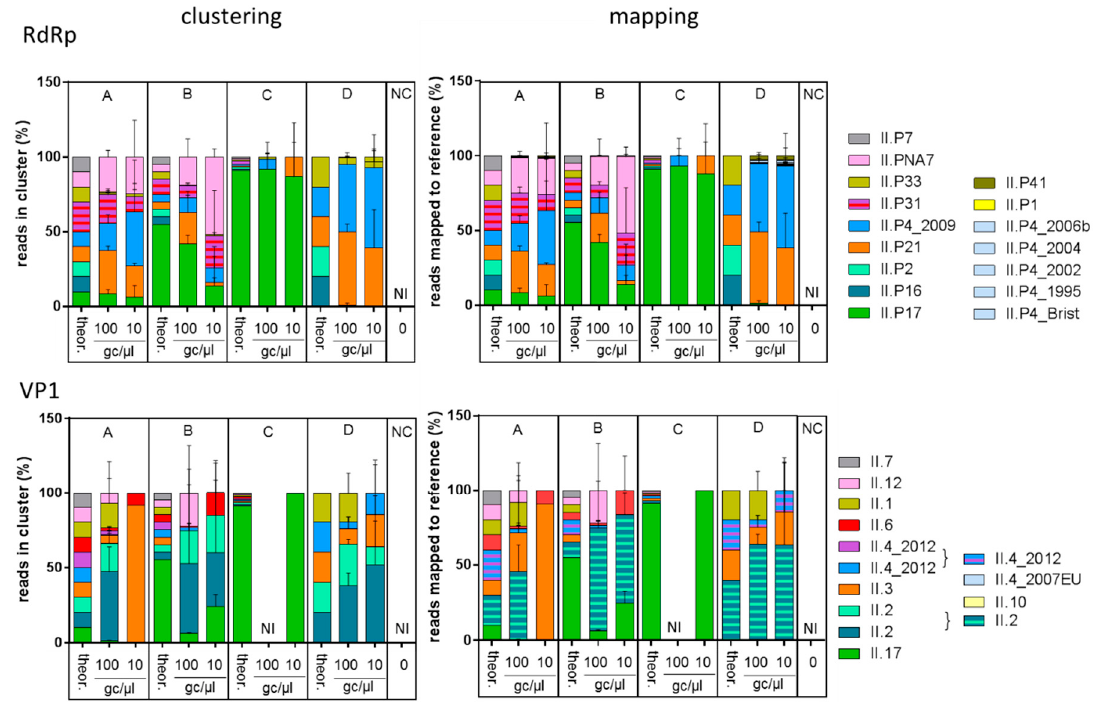
Figure 1. Relative abundance of NoV GII P-types and genotypes identified in the artificial samples. For each nucleic acid pool (A, B, C, D) and dilution (100 and 10 gc/ μ l), and the negative controls (NC), the proportion of reads assigned to a given genotype is depicted as the mean of the replicates with the standard deviation as error bars, for clustering (left) or mapping (right) analysis of RdRp (top) and VP1 (bottom). The theoretical composition is also depicted for comparison. Colors are matched between RdRp and VP1 graphs according to the NoV strains that were used to generate the samples (example: GII.12[PNA7] = S23 = pink). When unable to differentiate two strains with the same RdRp (P31) or genotype (GII.2, GII.4), both colors were used as stripes. NI: not identified.